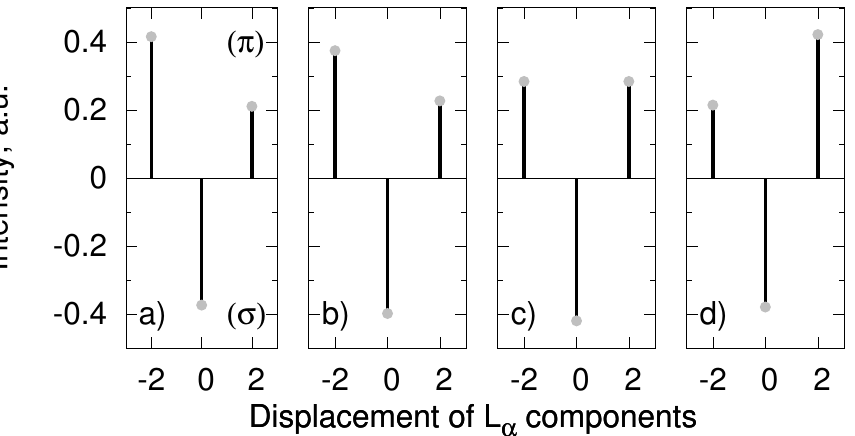
Figure 4. The Stark effect for the Lyman- α line excited by proton impact at collision energy of 50 keV/u and by electrons with temperature of 3 keV. The results of the calculation are shown for angles α = 0 ( a ), α = π /4 ( b ), α = π /2 ( c ) and α = π ( d ) between the axis of collision and the direction of electric field taking into account the cascades from n = 3. For the statistical intensities the ratio between components π ± : σ 0 = 1:2, and for the dynamical intensities all three components are equal. The σ component is 2 shown with negative sign for better visibility. The displacement is given in units of 3¯ hF a Plank constant, F is the strength of electric field, m e is the mass of electron, e is the electron charge, and c is the speed of